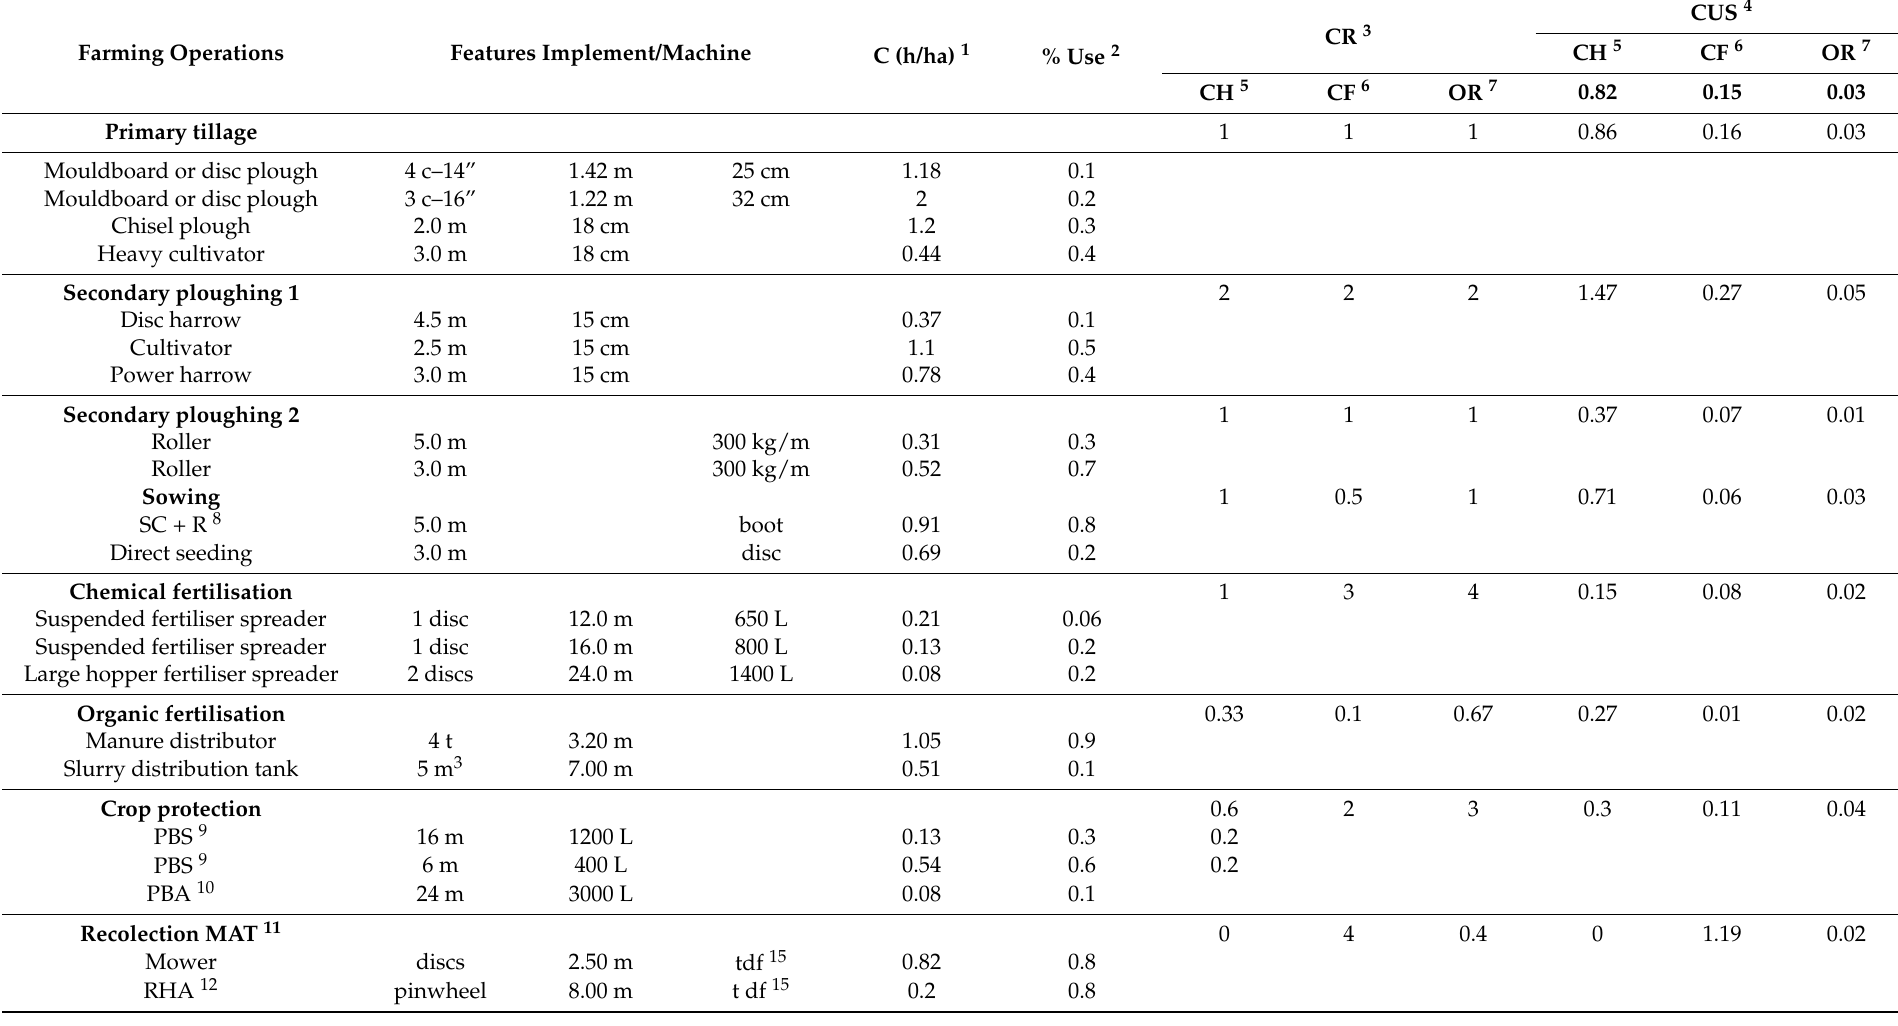
Table A1. Determination of the average mean yield